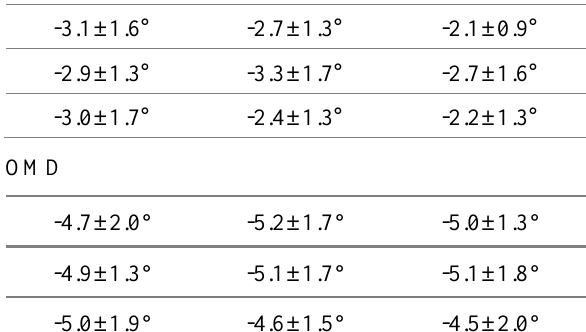
Figure 3: Bland–Altman analysis of the primary position in the Hess screen test and the OMD Examination 2: Examination of reproducibility